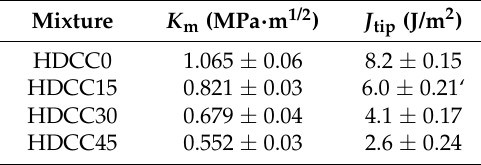
Table 5. Fracture toughness of HDCC mortar.